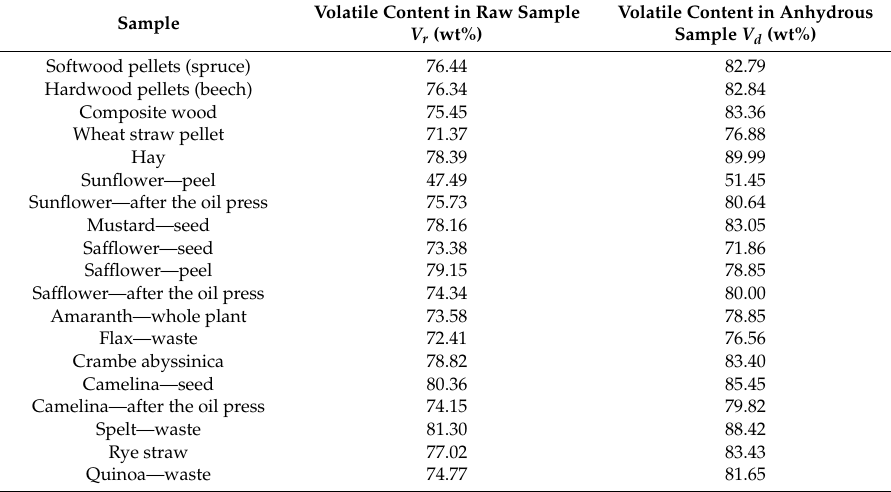
Table 5. Results of the determination of volatile